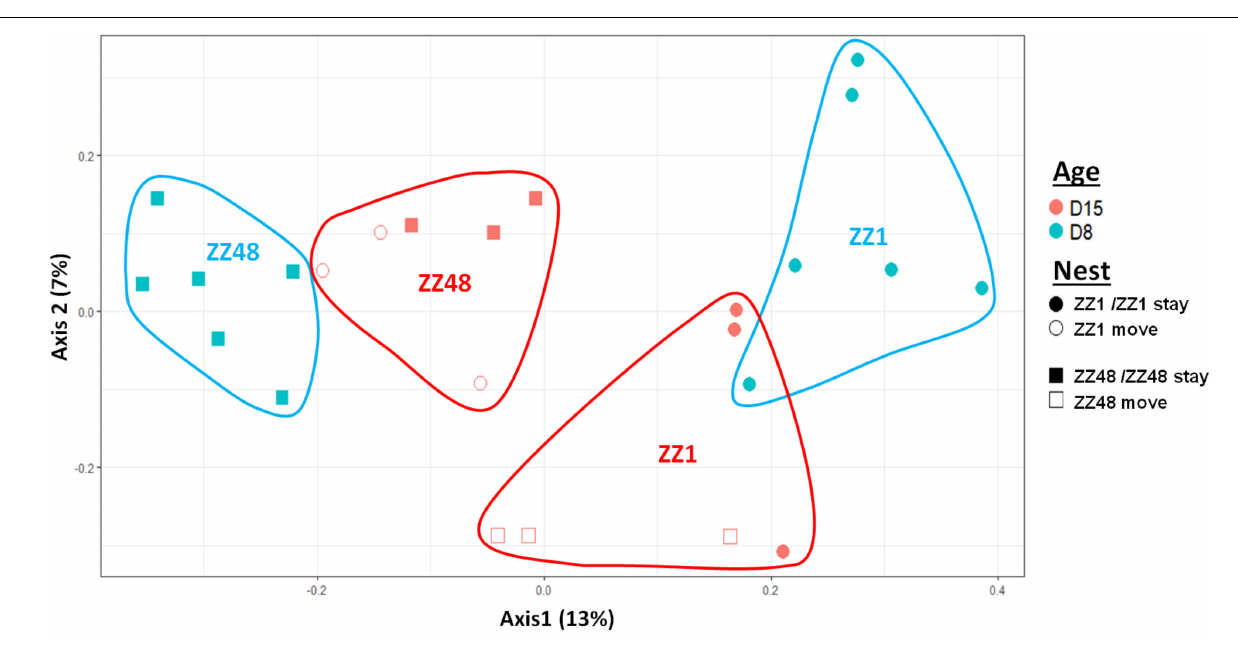
FIGURE 7 | MDS ordination based on a presence–absence similarity matrices of the gut microbiota of the nestlings of a set of cross-fostered nests. Nestlings remaining in their nest of origin are tagged “stay” and those moved to another nest are tagged “move.” Numbers in parenthesis refer to the variance explained by the ordination